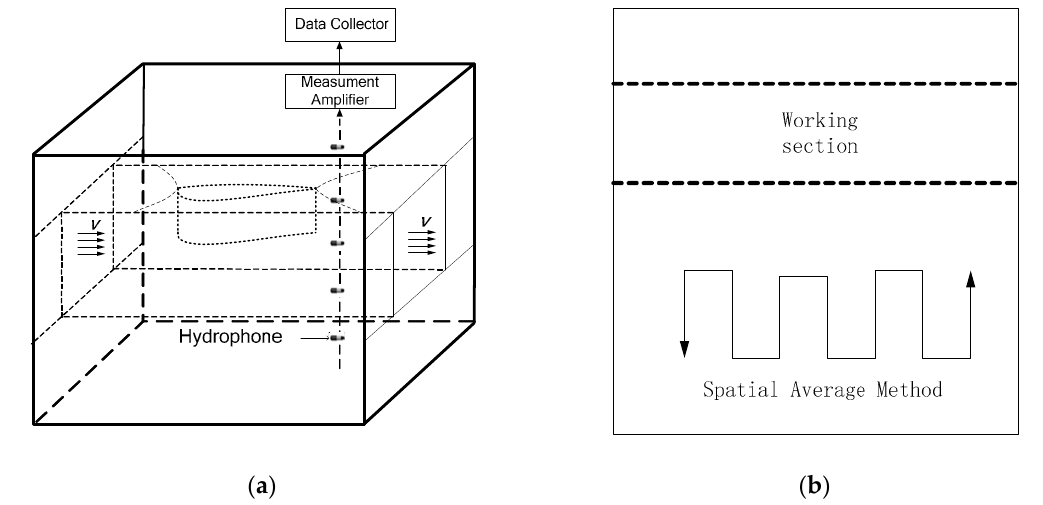
Figure 26. The diagram of the experimental measurement. ( a ) The composition of the vertical hydrophone array; ( b ) the spatial average method.